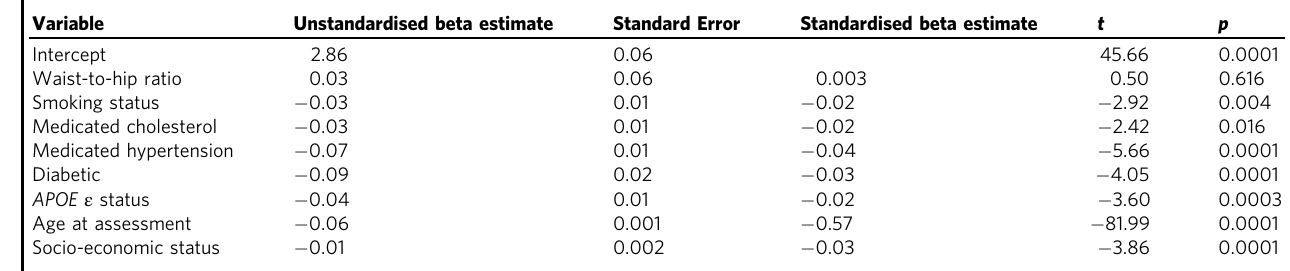
Table 1 Cerebrovascular risk predictors of executive function.